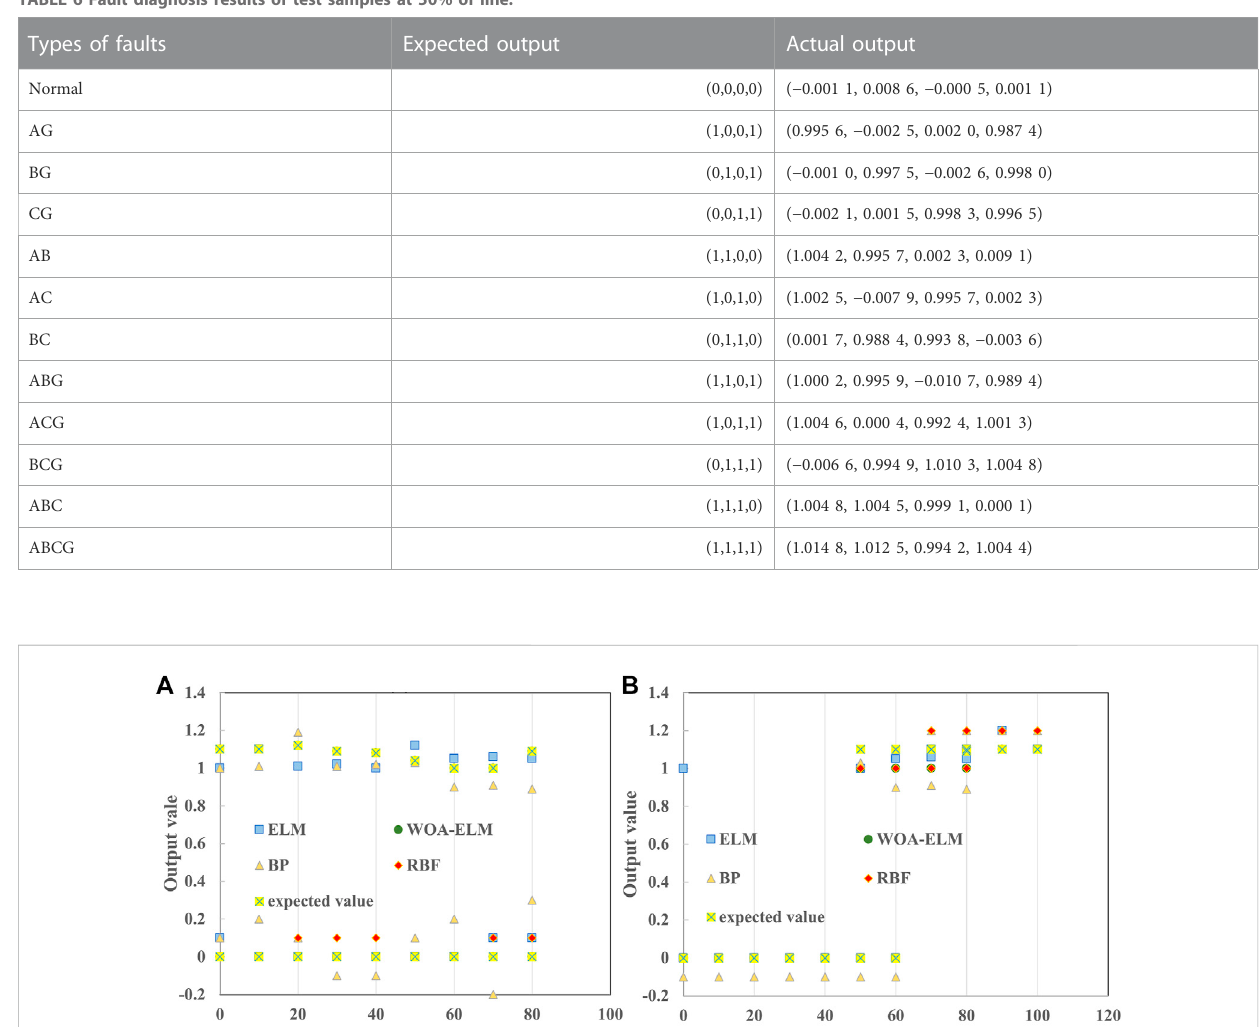
TABLE 6 Fault diagnosis results of test samples at 50% of line.